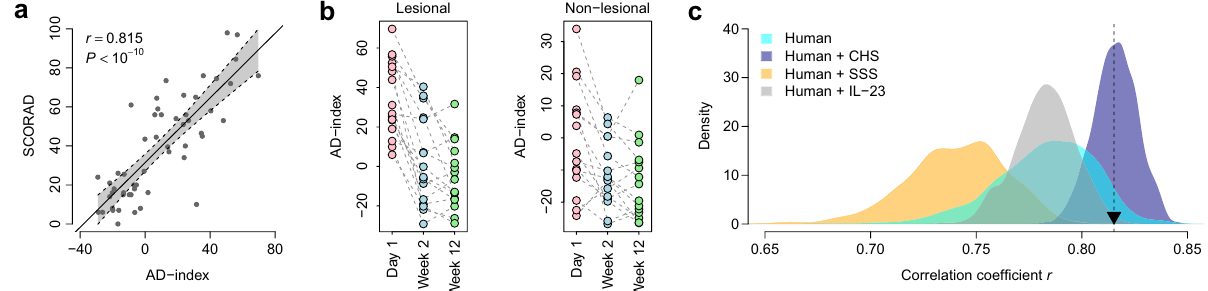
Figure 3. Prediction of atopic dermatitis (AD) severity using the 36 gene-based AD index. ( a ) Correlation between AD index and SCORAD index for lesional samples from the US2 cohort. ( b ) Comparison of pre- and post-treatment AD indexes. ( c ) Evaluation of the translational value of murine models in AD biomarker development. The cyan area indicates the distribution of correlation coefficients r for 1,000 resampled gene signatures randomly selected from the human gene pool containing AD-related genes commonly dysregulated in the German (DE) and Swedish (SE) cohorts. The navy and orange areas indicate the distribution of r for 1,000 resampled gene signatures randomly selected from the human + contact hypersensitivity (CHS) and human + skin-scratching stimulation (SSS) models, respectively. The grey area indicates the distribution of r for 1,000 resampled gene signatures randomly selected from the Human + IL-23 gene pool. The black triangle represents the r -value of our 36-gene